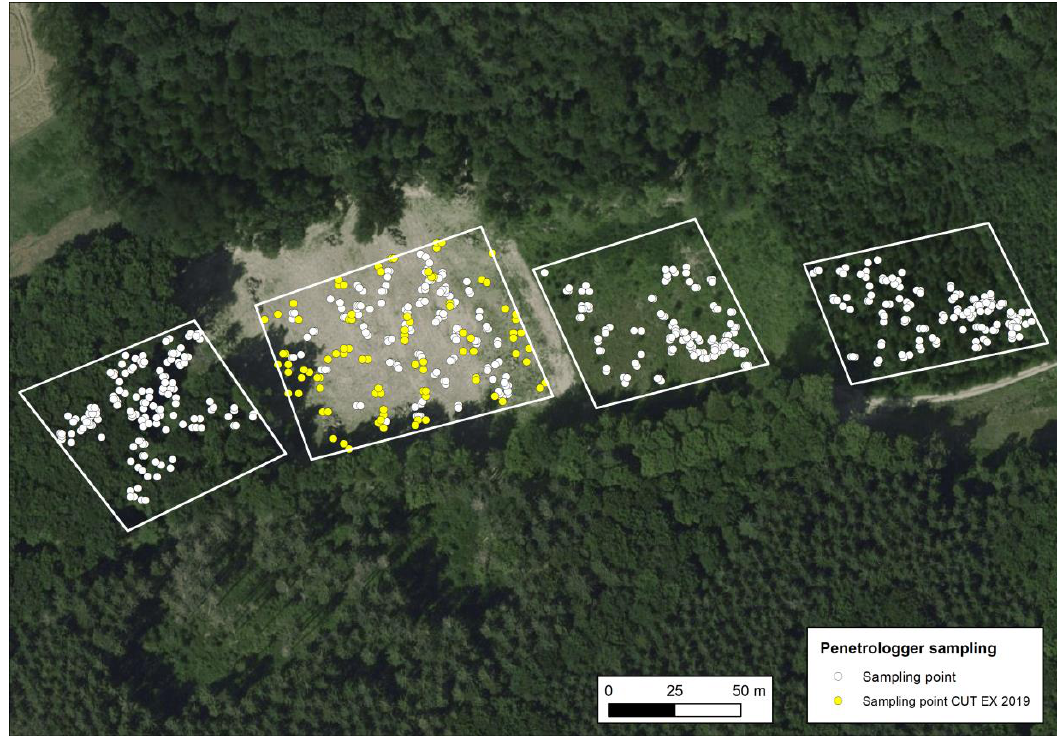
Figure 4. Penetrologger sampling points. Aerial photography provided by LVermGeo RLP (2019).